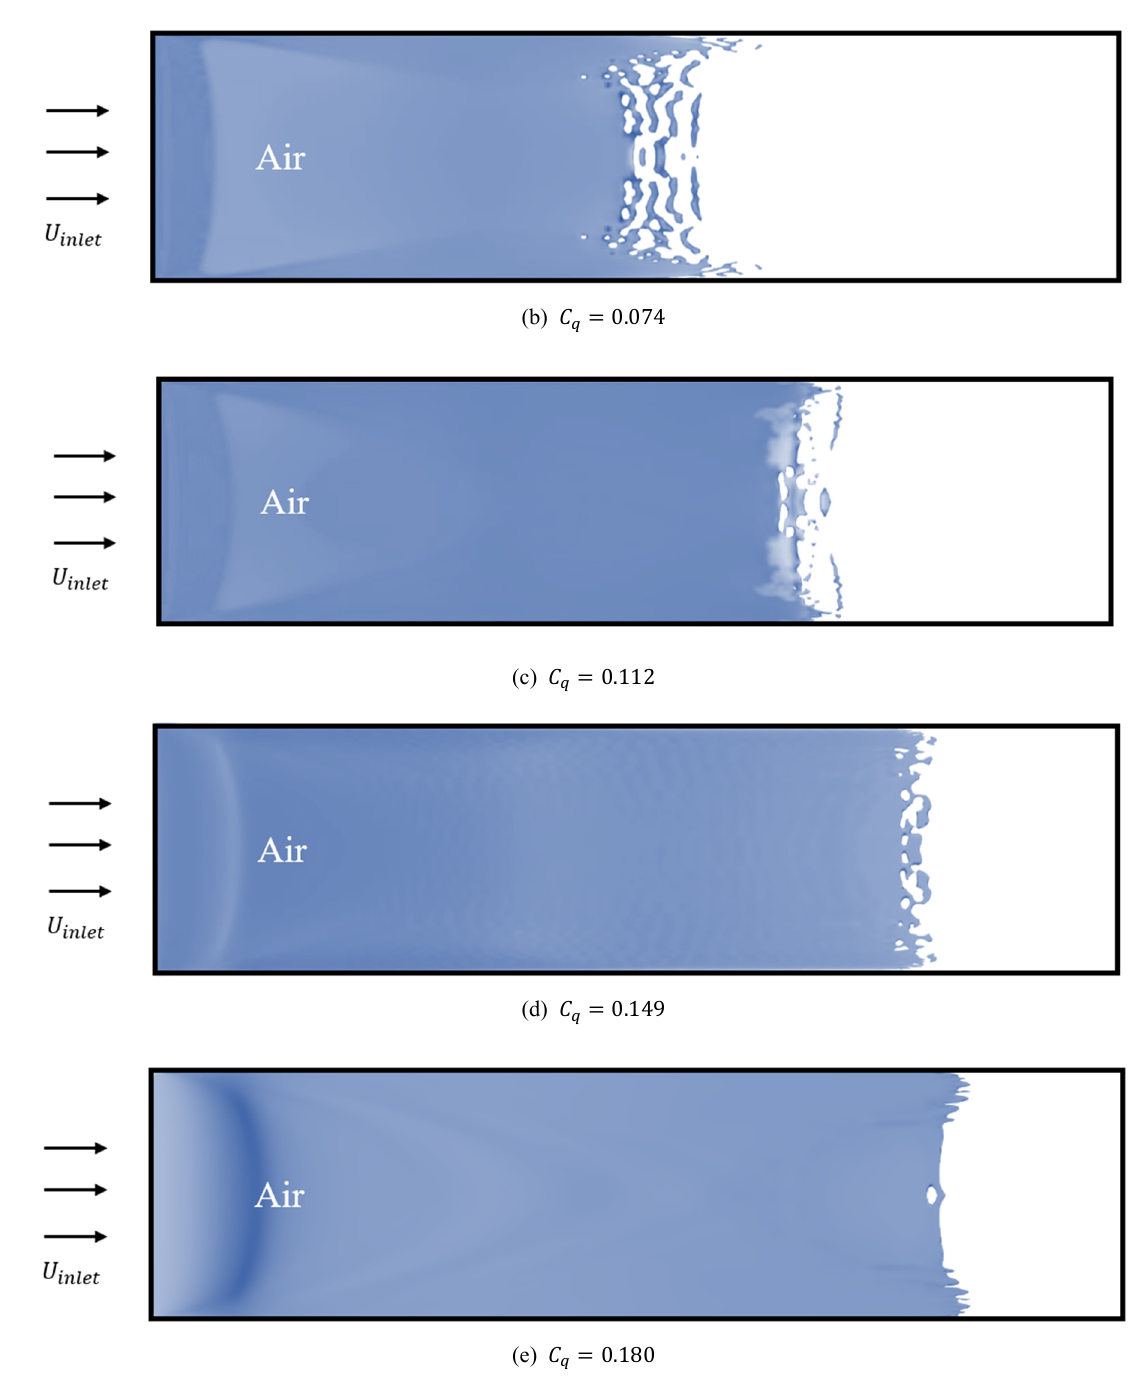
Table 4. Drag and drag reduction.